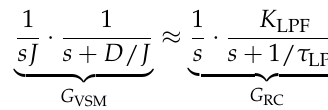
where K LPF is the gain of the filter and τ LPF its time